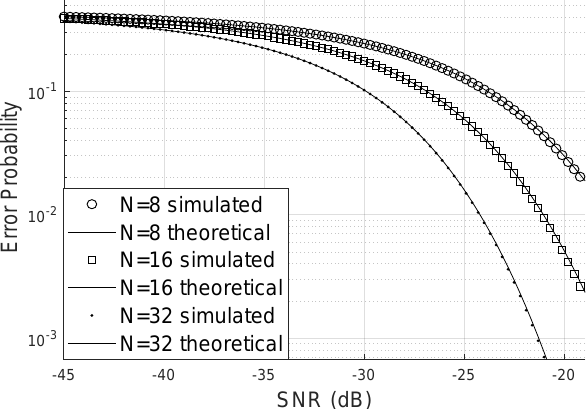
Figure 6. Error probability for uniformly distributed phase errors.